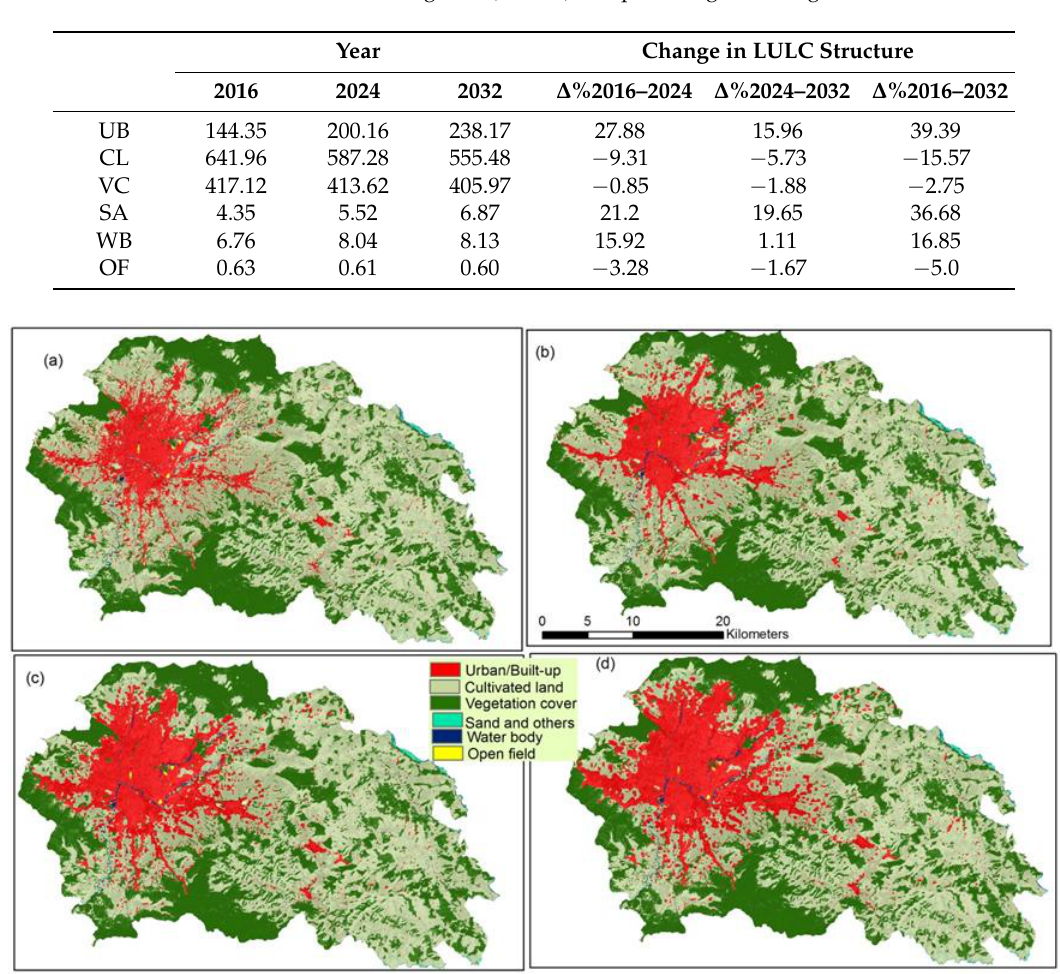
Table 7. Distribution of LULC categories (in km 2 ) and percentage of changes for 2016–2032.